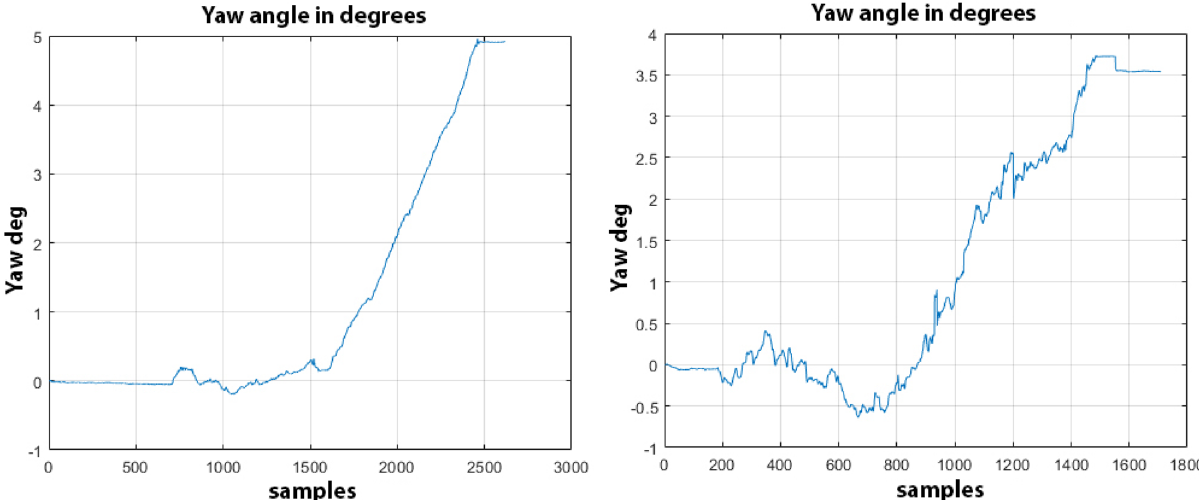
Figure 16. Angle deviation on straight trajectory on concrete, on the left, and the angle deviation for asphalt, on the